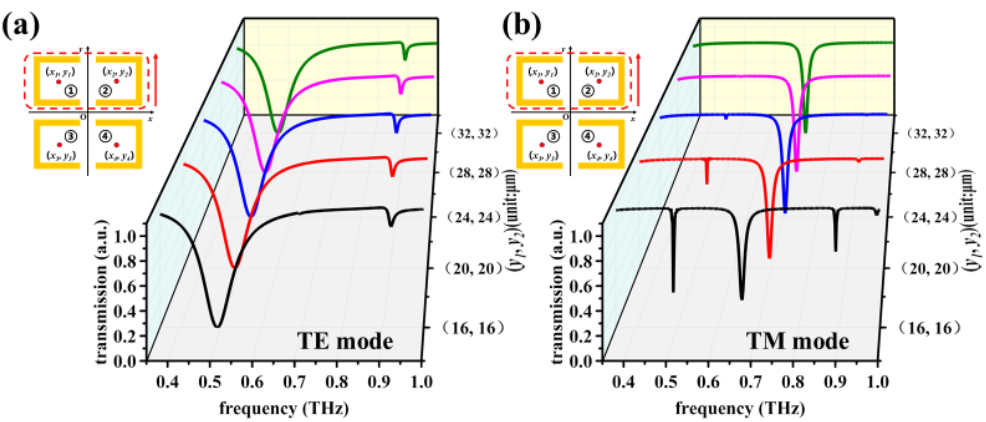
Figure 3. Simulated transmission spectra of the RTM device obtained by moving the SRR-1 and SRR-2 meta-atoms along positive y -axis direction in ( a ) TE and ( b ) TM modes.